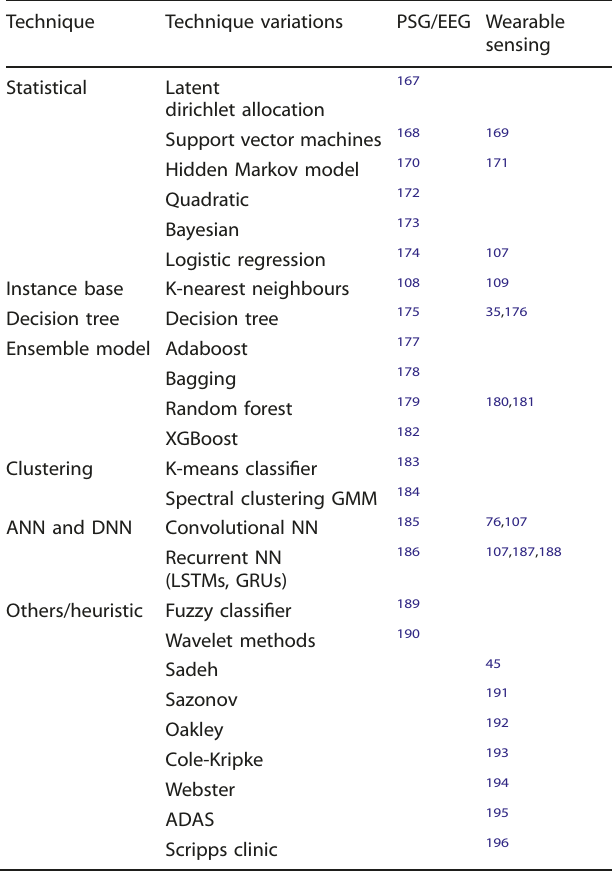
Table 1. Sleep classi fi cation techniques across different sleep-sensing